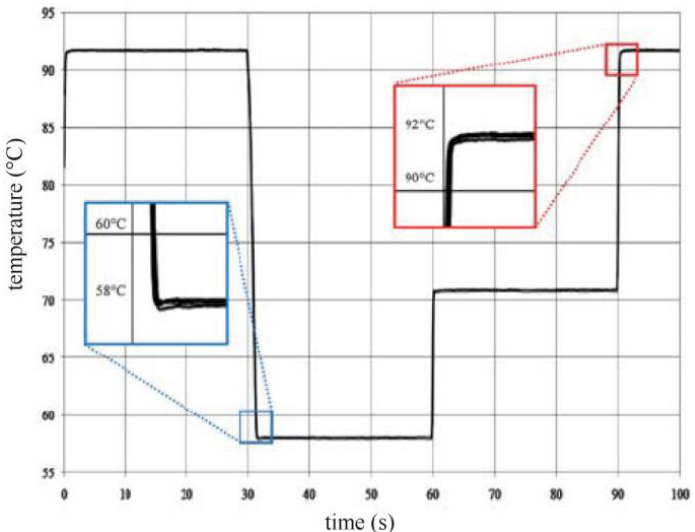
Figure 27. Thermal cycling profile based on selected temperatures of 92, 58 and 71 °C. Reprinted with permission from [57]. Copyright 2010, Royal Society of Chemistry.